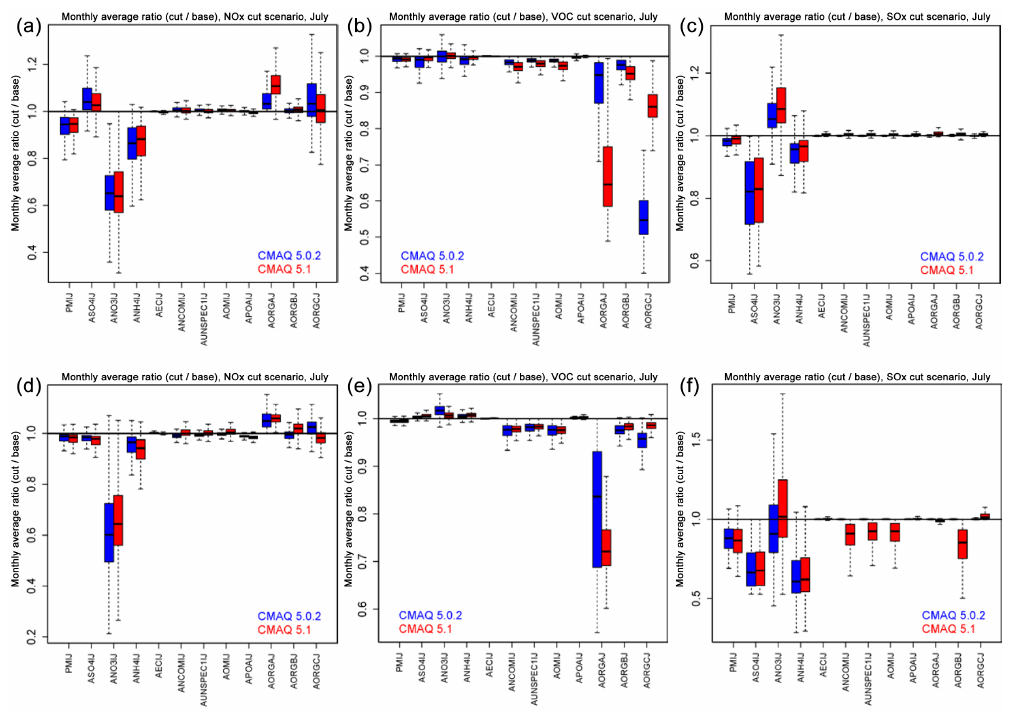
Figure 18. Box plots of monthly average ratio values (cut / base) of PMIJ (total PM 2 . 5 ), ASO4IJ, ANO3IJ, ANH4IJ, AECIJ, ANCOMIJ, AUNSPECIJ, AOMIJ, APOAIJ, AORGAJ, AORGBJ and AORGCJ for v5.0.2 (blue) and v5.1 (red) for a 50% cut in anthropogenic NO x (a, d) , VOC (b, e) and SO x (c, f) for January (a–c) and July (d–f)